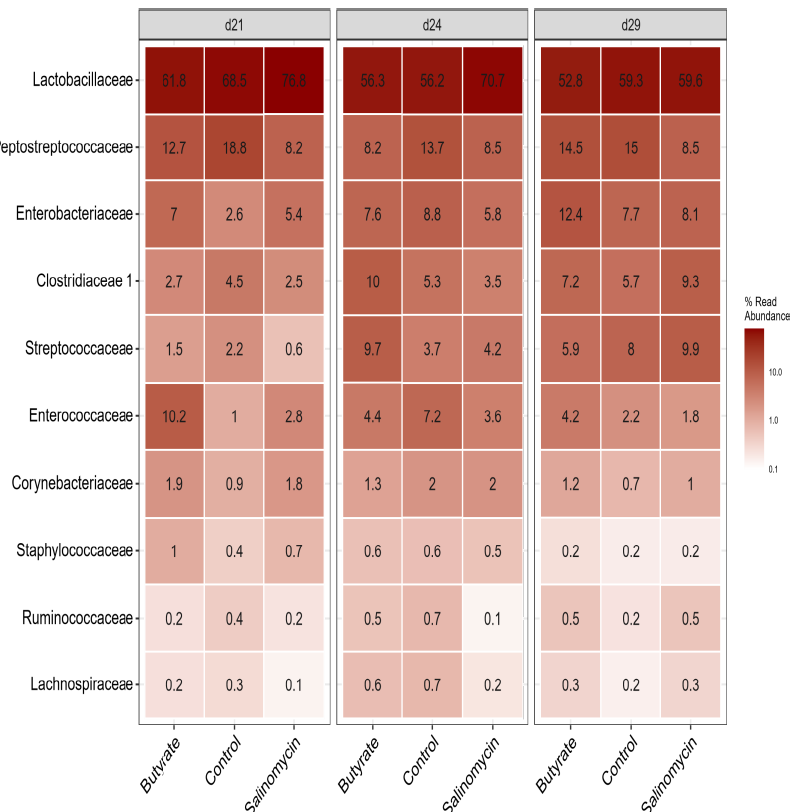
Figure 5. Heatmap showing the relative abundance of the top 10 most abundant microbiota at the family level across all ileum samples (irrespective of treatment or age) and visualized for each age and treatment group, separately. The samples were collected on days 21, 24, and 29 of age from chickens administered butyrate (UltraGuard™-DUO, 500 mg/kg), salinomycin (Sacox ® , 69 mg/kg), or no dietary supplement (control).